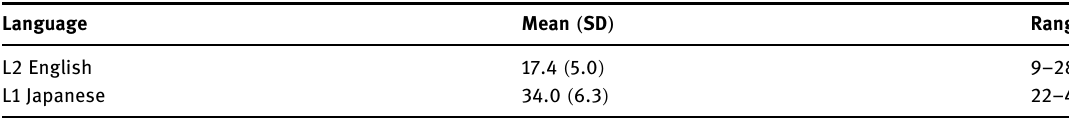
Table 2: Self - perception of L2 and L1 abilities ( Likert points )